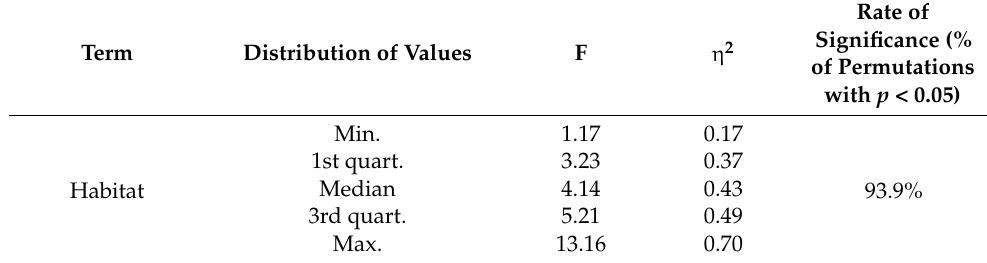
Table 3. Summary statistics of ANOVA results derived from 999 stratified resampling of the original dataset based on the plot numbers given by the decay of habitats MultSE . Fisher values (F) and measures of effect size ( η 2 ) are shown along with the overall rate of significance of the